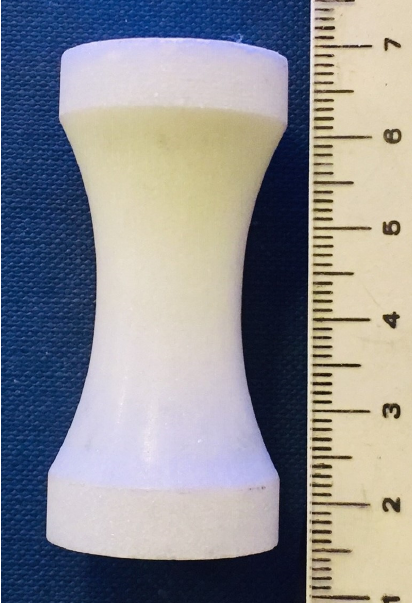
Figure 1. Geometrical form of the sample of Carrara marble deformed in axial compression for this study (cm scale).